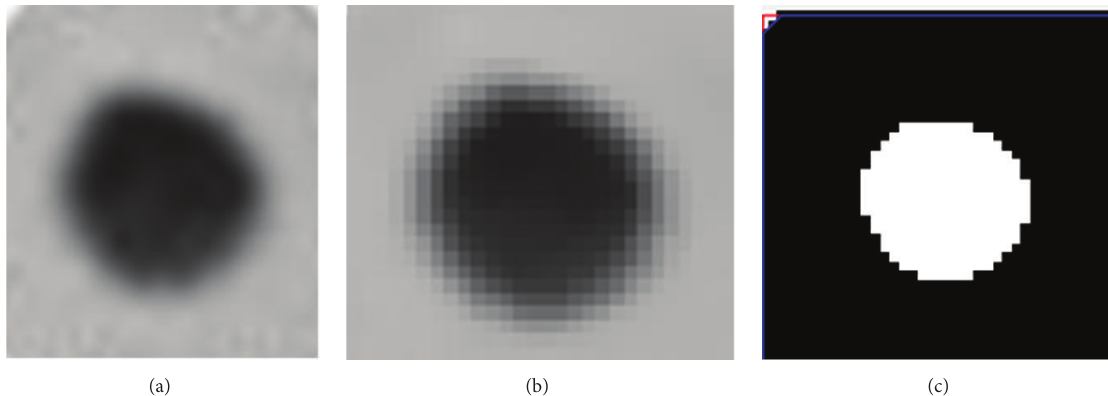
Figure 4: The results of image preprocessing and segmentation. (a) The original image. (b) The image after preprocessing. (c) The image after segmentation.